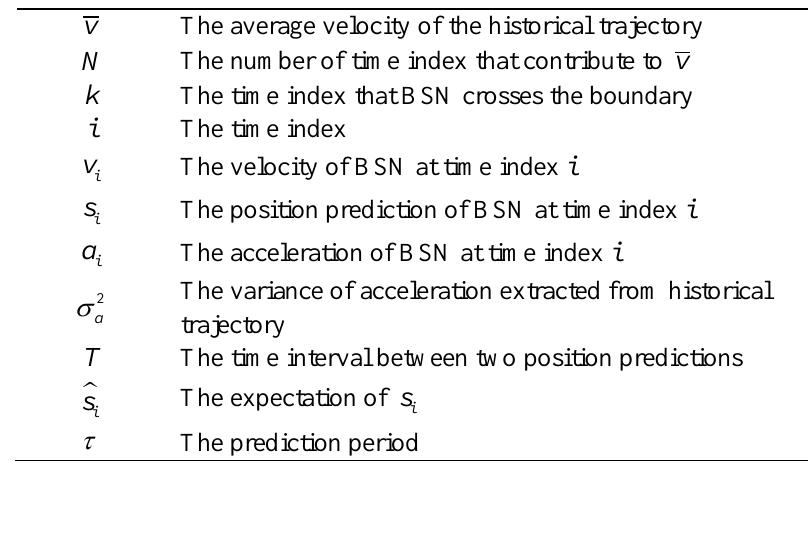
Figure 3. Position